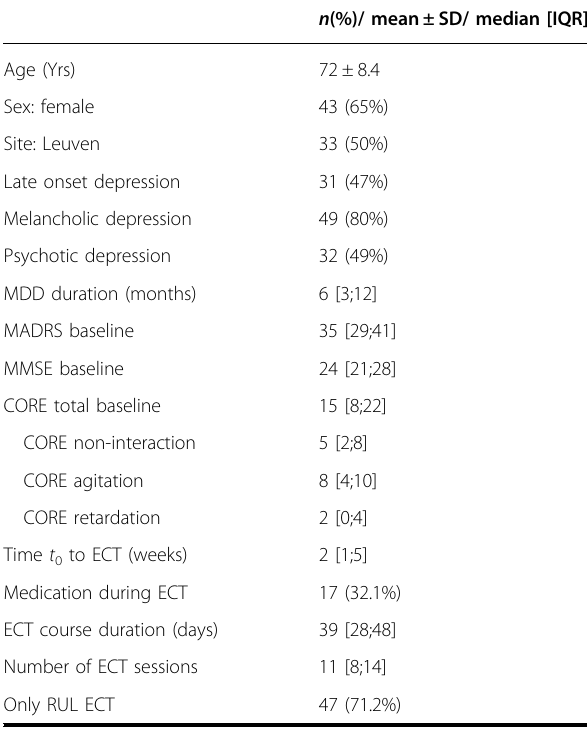
Table 1 Patient characteristics.